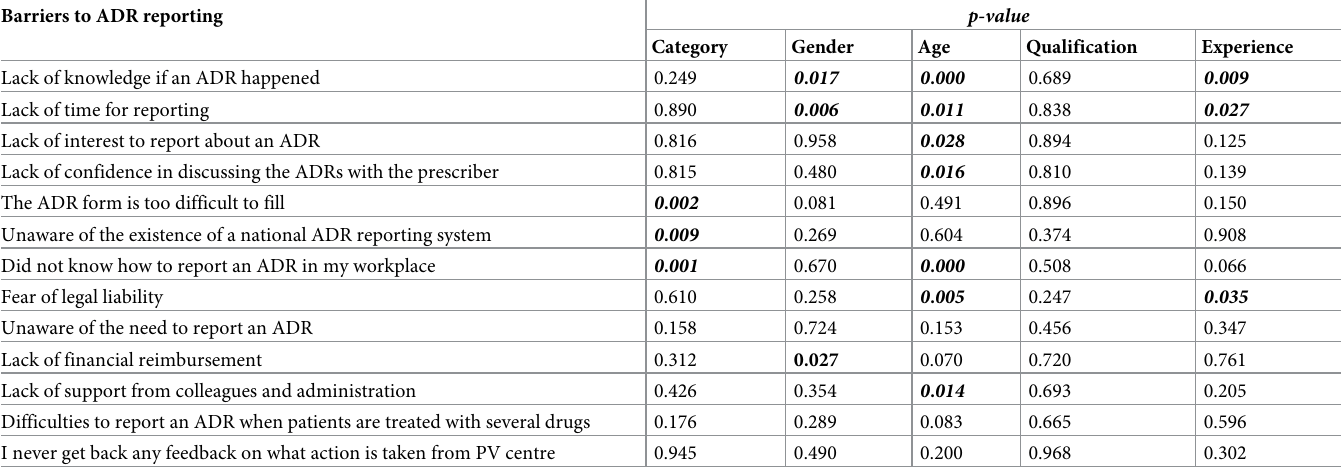
Table 4. Significance of ADRs related barriers based on demographic characteristics.